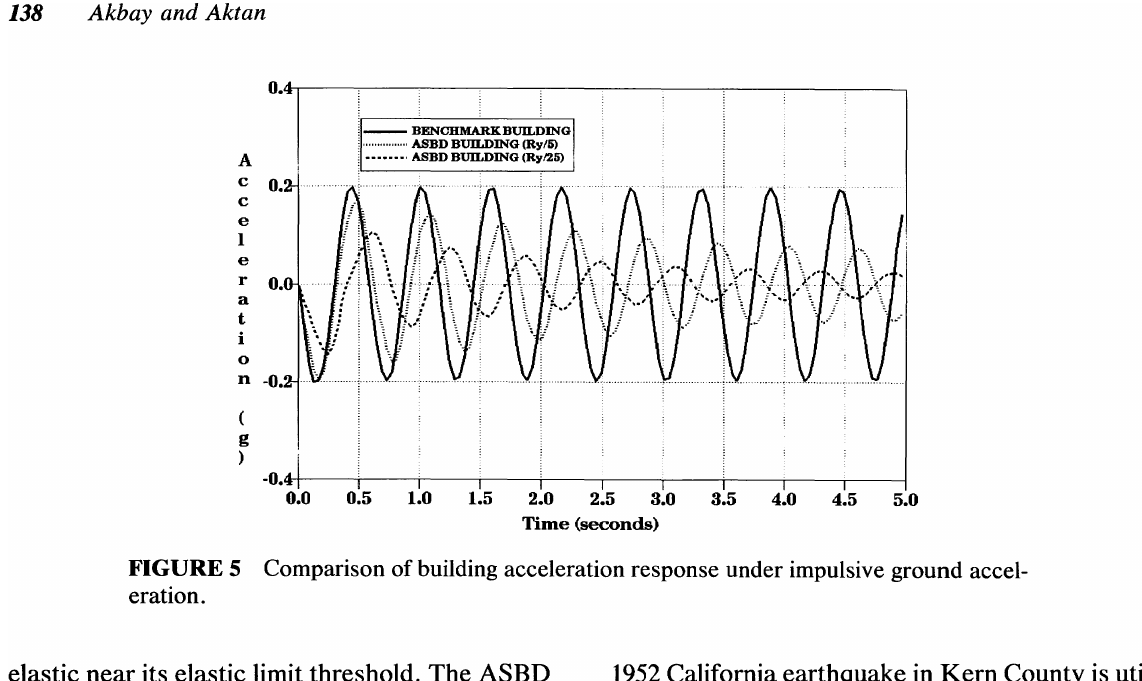
FIGURE 5 Comparison of building acceleration response under impulsive ground accel eration.